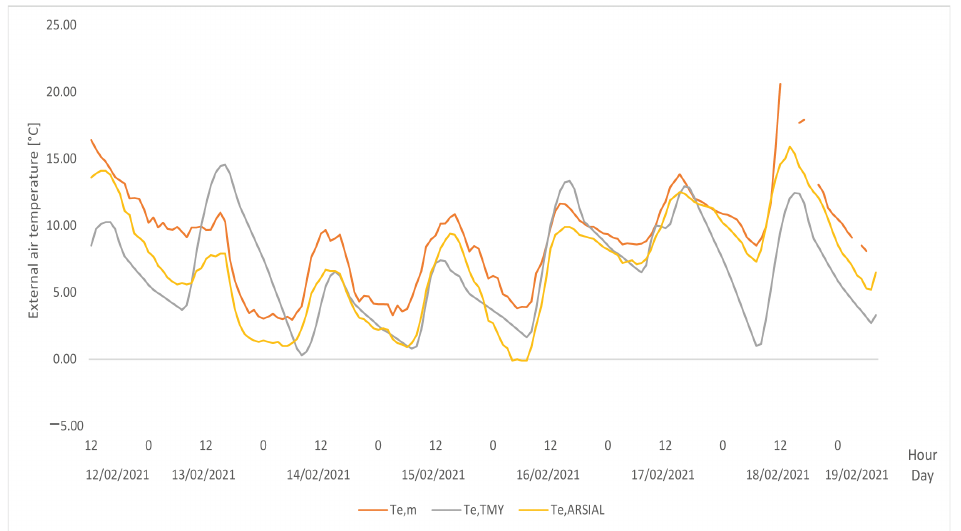
Figure 6. Outdoor air temperature: difference between original Meteonorm file, ARSIAL weather database and measurements.